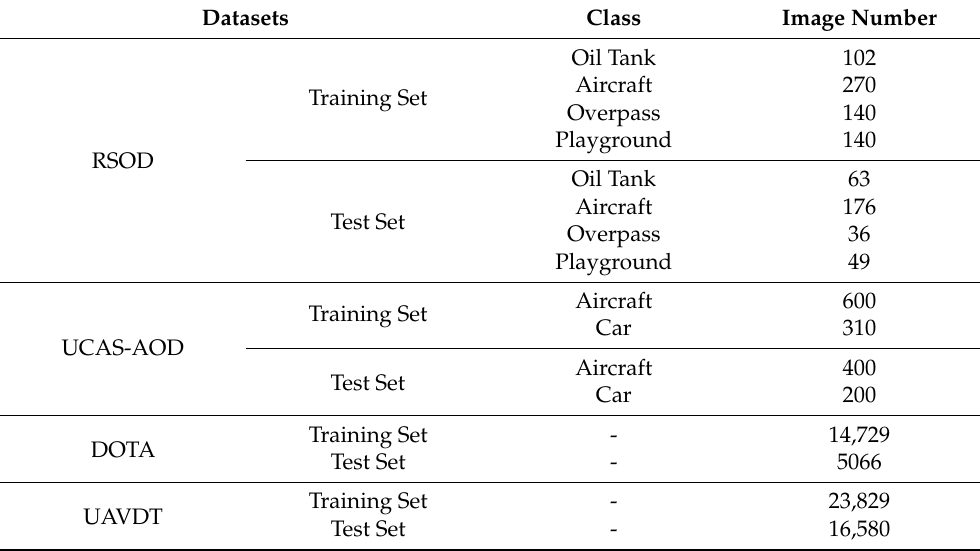
Table 2. Division of the RSOD, UCAS-AOD, and DOTA